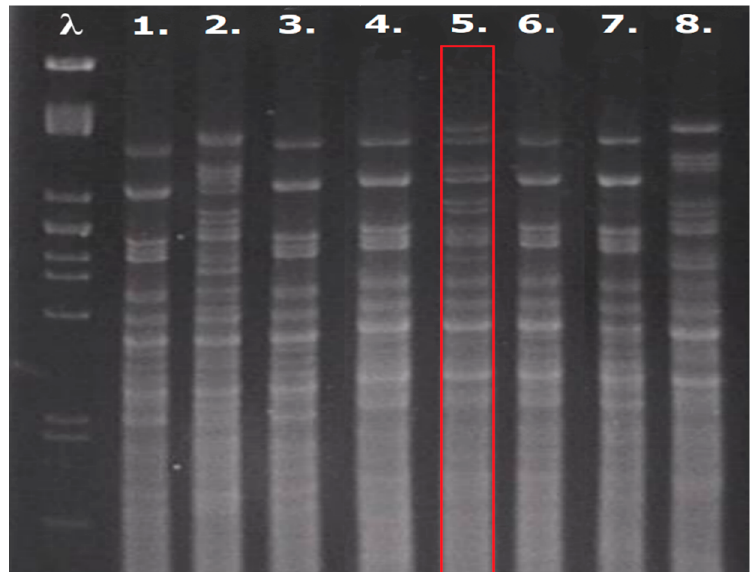
Figure 2. Hinf I restriction analysis of the total genomic DNA of hybrids. λ ( PstI λ ): ladder, 1( Hyb1ACO1 ), 2( Hyb2ACO1 ), 3( Hyb1KGD1 ), 4( Hyb2KGD1 ), 5( Hyb1CIT1 ), 6( Hyb2CIT1 ), 7( S. mikatae ), 8( S. cerevisiae CIT1 ). Red section (line 5) represents hybrid yeast which inherited mtDNA from both parental strains.